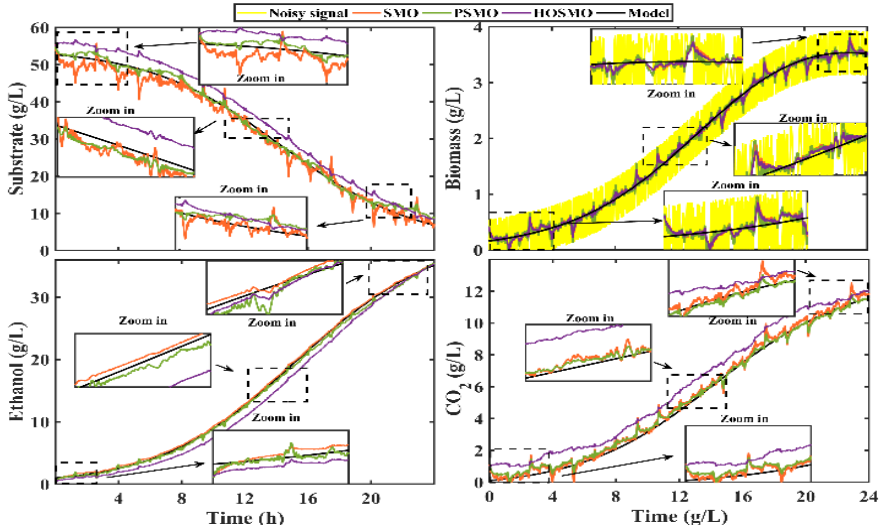
Figure 8. Simulation of the observation structures.